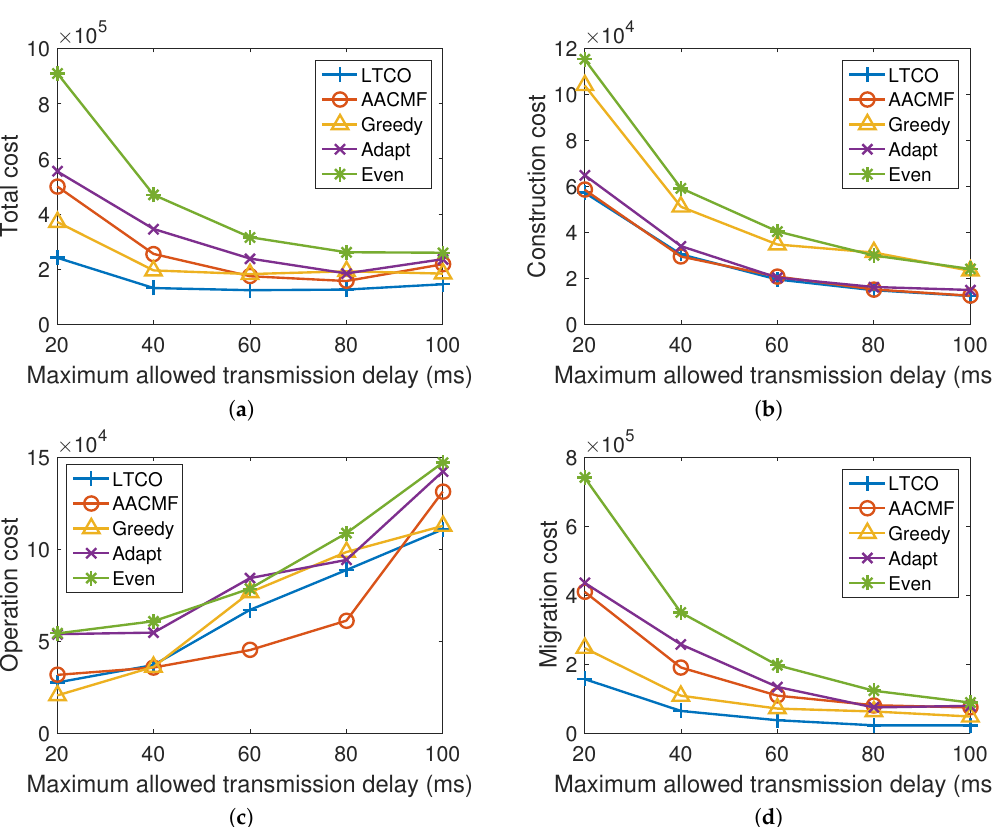
Figure 6. Impact of varied parameter D for real mobility